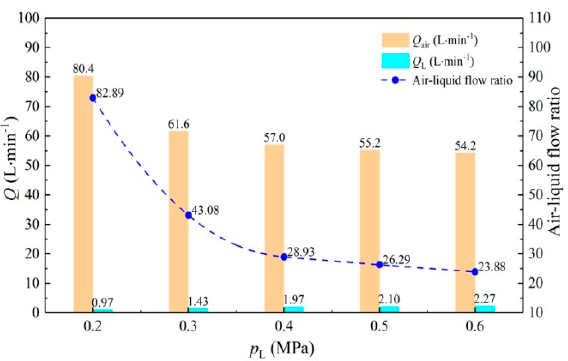
Figure 5. The impact of water pressure on the air–liquid flow ratio and the nozzle